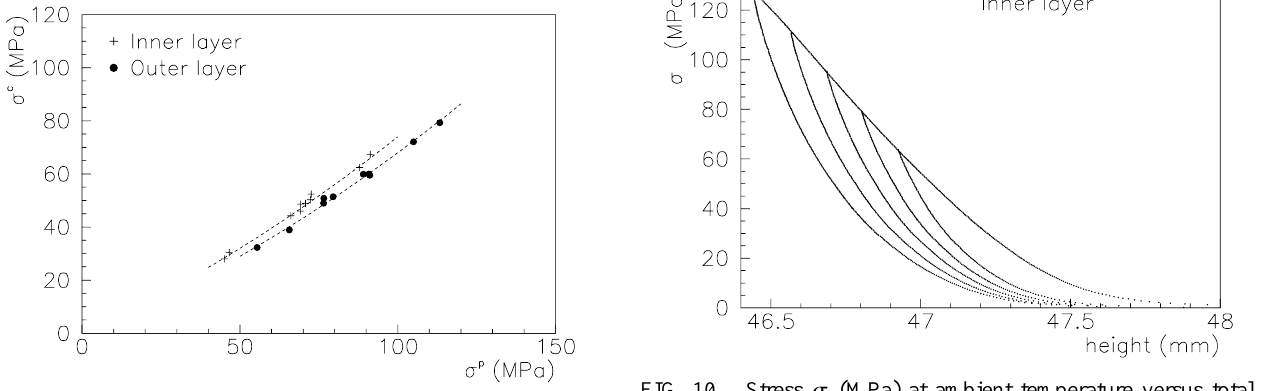
FIG. 9. Residual azimuthal stress on the coil s c (MPa) versus peak s p stress (MPa) during five collarings of the 1 m long prototype.